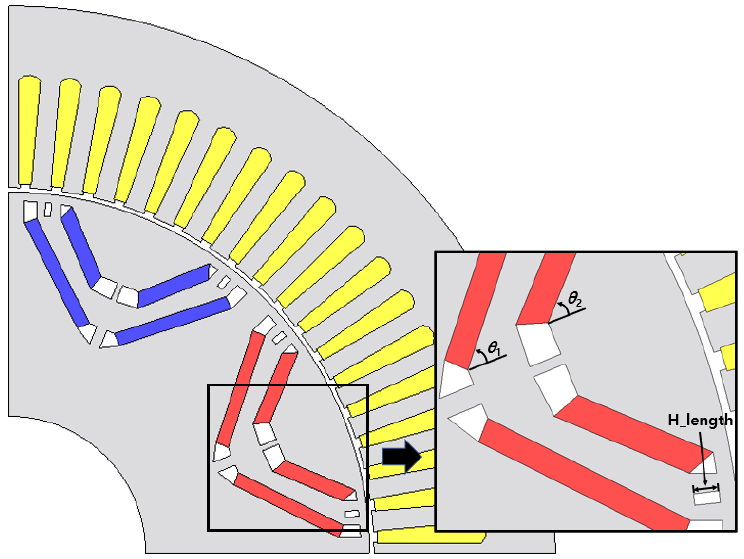
Figure 10. Configuration of the optimal model and design variables.